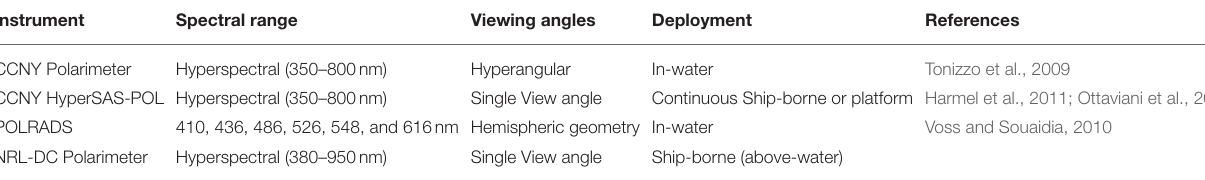
TABLE 2 | List of in-situ polarimeters for ocean applications.